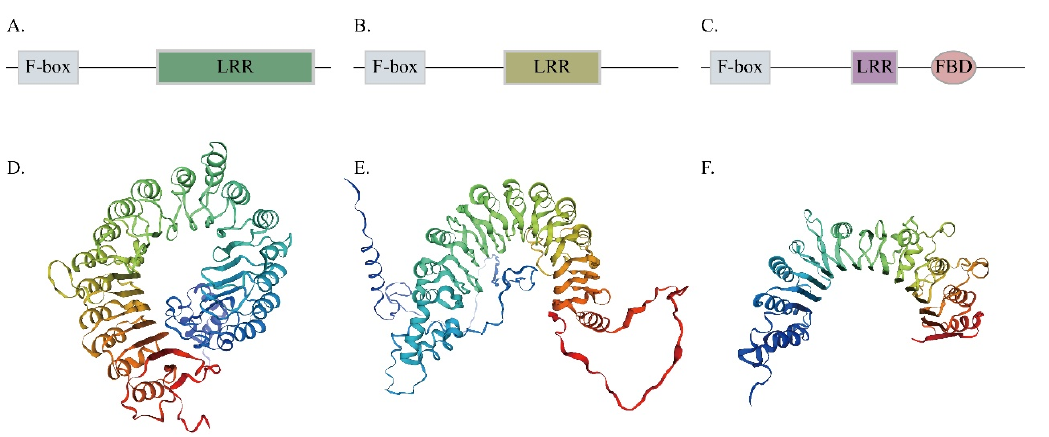
Figure 1. The classification of FBXL proteins. ( A – C ) Group-I, Group-II, and Group-III domain structures, respectively. ( D – F ) Three-dimensional structure of representative genes of Group-I, Group-II, and Group-III.